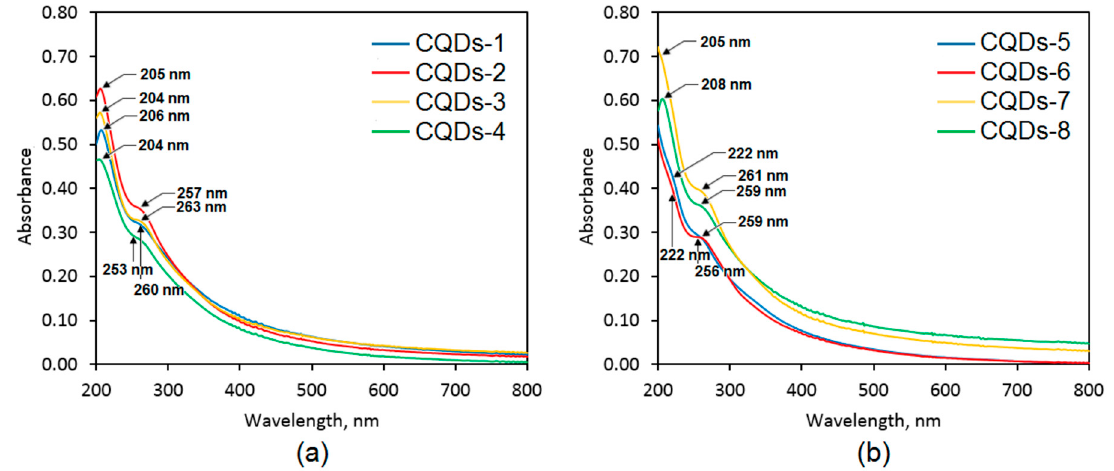
Figure 5. UV-Vis spectra of the prepared samples: ( a )—CQDs-1–CQDs-4 and ( b )—CQDs-5–CQDs-8.